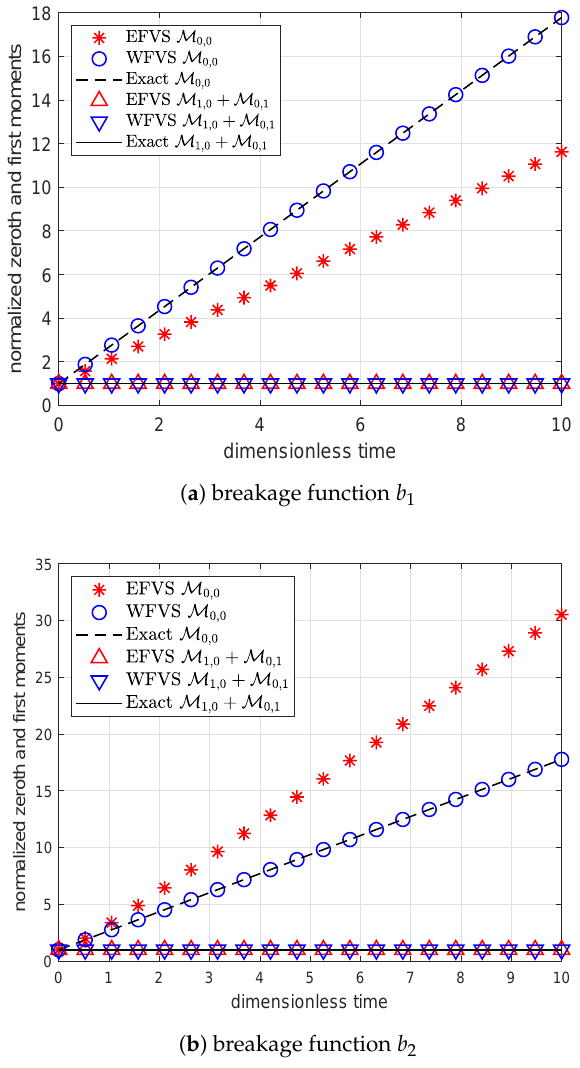
Figure 3. Comparison of zeroth- and first-order moments with selection function S = x + y , and breakage functions b 1 , b 2 . Table 4. Relative error for the weighted moments at different grid points for the test case with S = x + y and breakage function b 1 at t = 10.